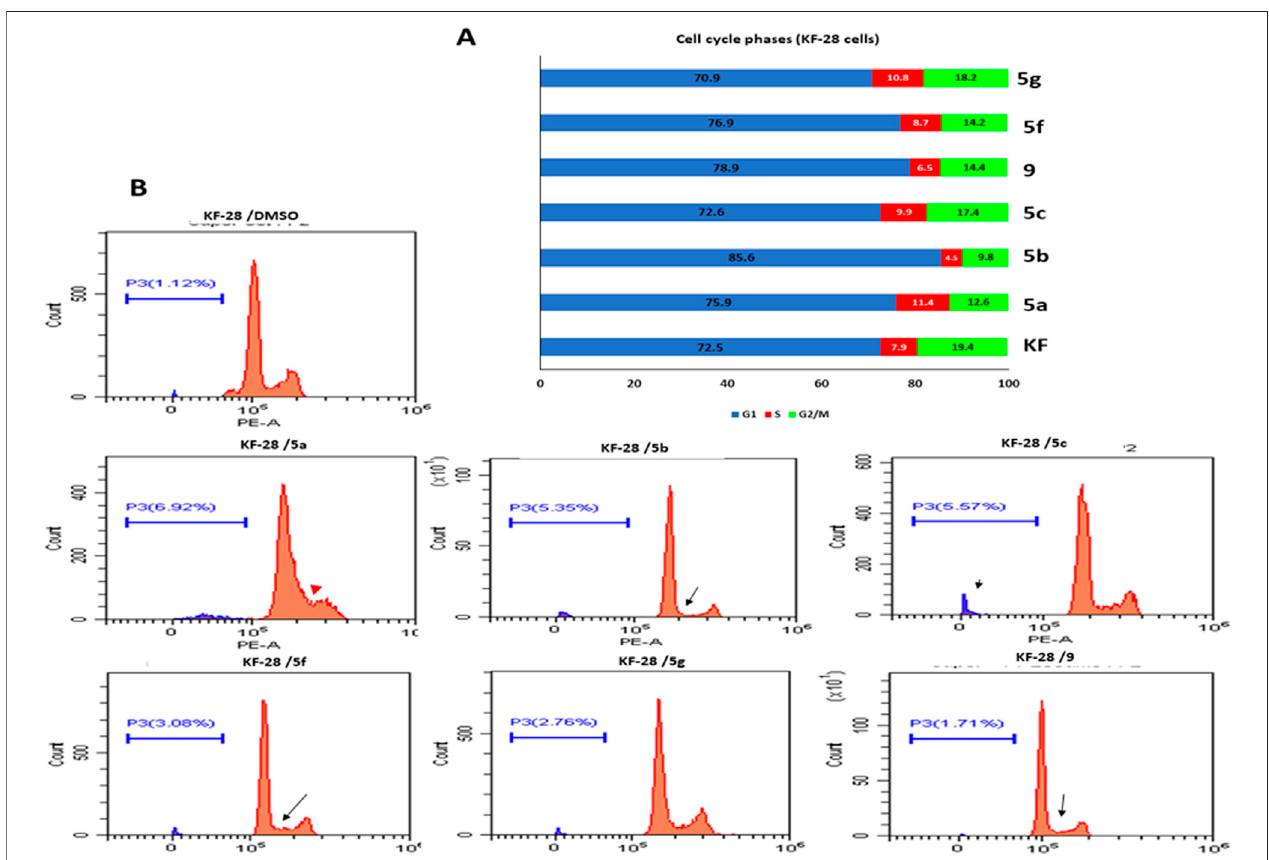
FIGURE1 | Effect ofselected compounds on cell cycle phases in KF-28 cell lines. (A) Representative cytographs show theeffect ofvehicle and compounds 5a – c, 5f,5g,and9onthedifferentcellcyclephasesofKF-28cellswhentreatedwitheachcompoundfortwodays. (B) Collectedresultsshowtheeffectofeachcompoundon different populations at each cell cycle phase.